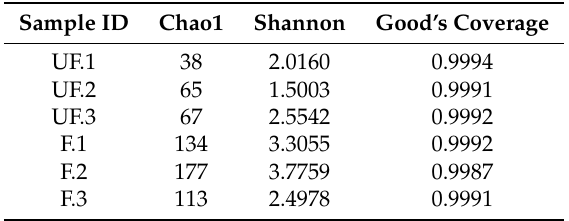
Table 2. α -diversity analysis of non-fertilized and fertilized eggs.